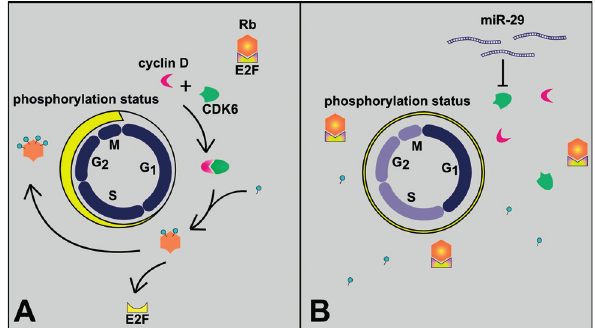
Fig. 2. MiR-29 function in cell cycle. (A) Cell cycle without miR-29 influence, (B) MiR-29 inhibits Cdk6 which cannot bind with cyclin D and phosphorylate Rb; therefore, cell is not dif-